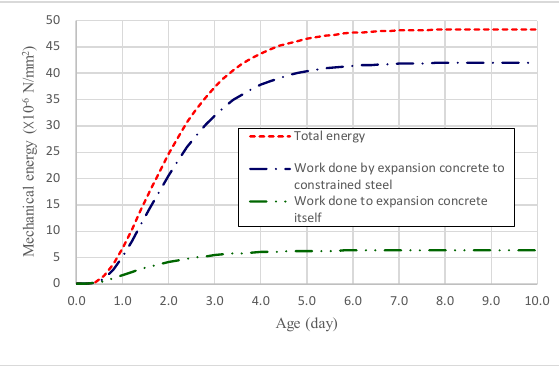
Figure 13. Relationship between the mechanical energy and